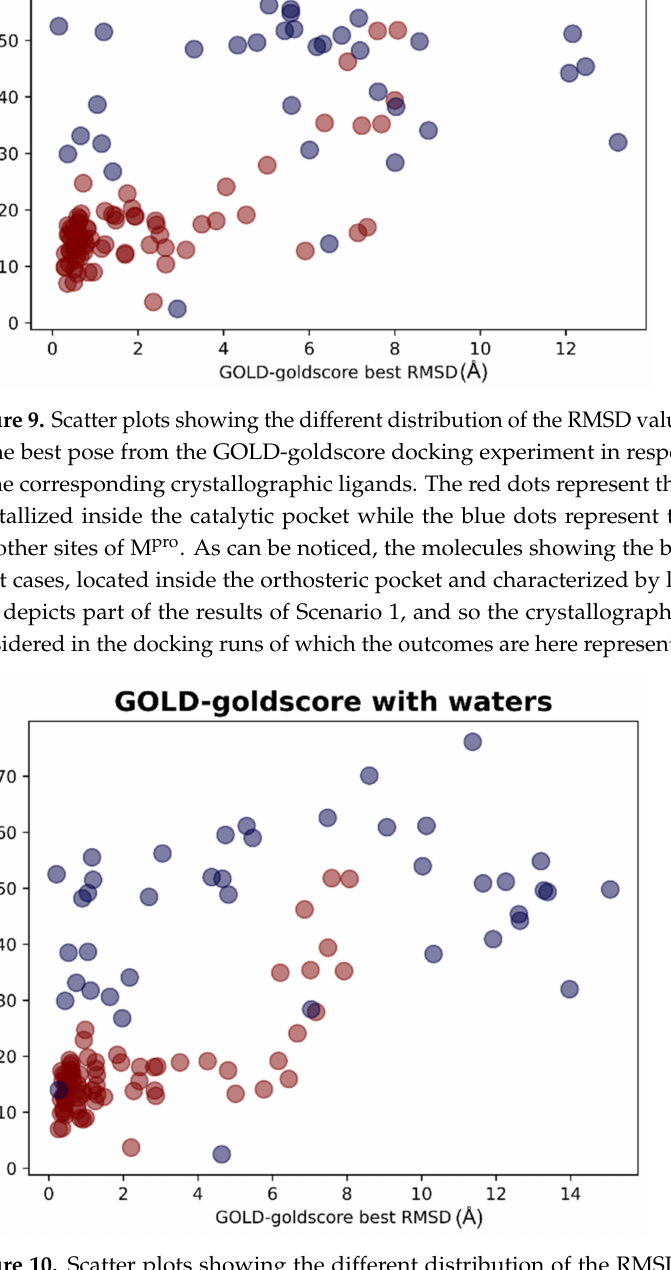
Figure 10. Scatter plots showing the different distribution of the RMSD values between the coor- dinates of the best pose from the GOLD-goldscore docking experiment in respect to the solvent exposure of the corresponding crystallographic ligands. The red dots represent the ligands that are originally crystallized inside the catalytic pocket, while the blue dots represent the ligands crystallized in the other parts of M pro . As can be noticed, the molecules showing the best values of RMSD are in most cases located inside the orthosteric pocket and characterized by low solvent exposure. This plot depicts part of the results of Scenario 2, meaning that the crystallographic water molecules at 5 Å or nearer to the ligand are also considered in the docking runs of which the outcomes are here